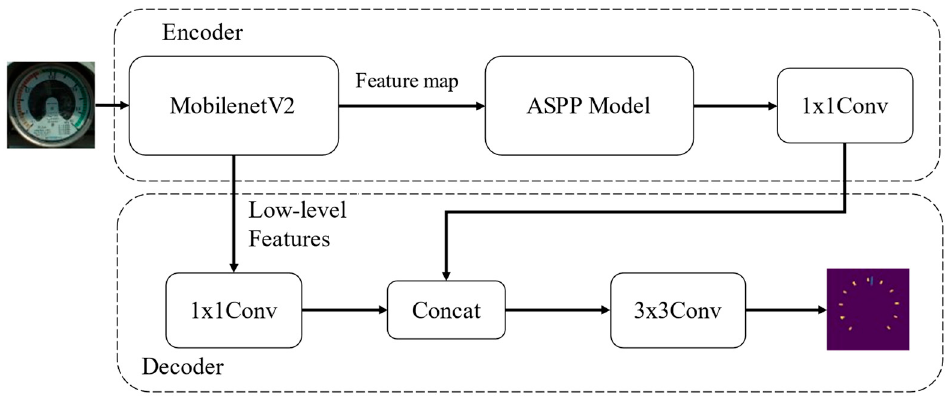
Figure 4. The Modules of Deeplabv3+.